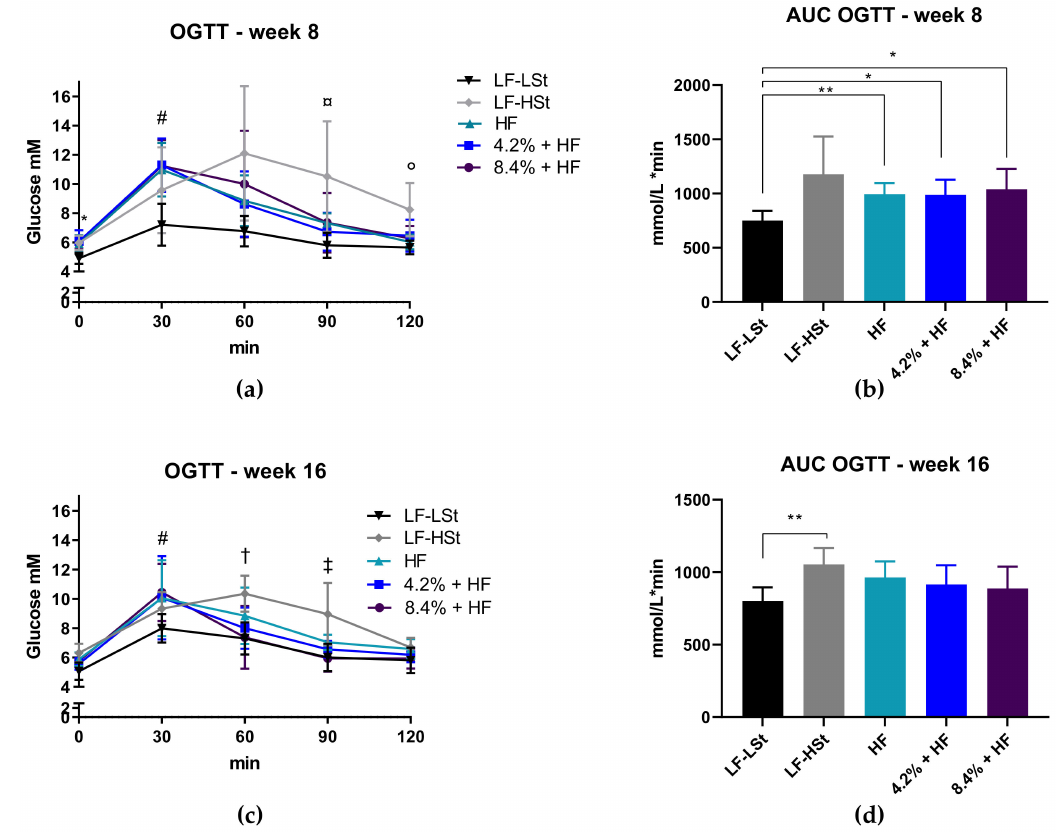
Figure 2. Oral Glucose Tolerance Tests. ( a ) Oral glucose tolerance test at week 8. Data are presented as means with SD and square root transformed data were analyzed by a repeated measures two-way ANOVA, and a Tukey’s test for multiple comparisons. n = 8 ( b ) Area under the curve for each group. Data are represented as means with SD, and analyzed by Welch ANOVA with a Dunnett’s test for multiple comparisons. n = 8 ( c ) Oral Glucose tolerance test week 16. Data are represented as means with SD, and analyzed by mixed effects model with repeated measures, and a Tukey’s test for multiple comparisons. n = 6–8 ( d ) Area under the curve for each group. Data are presented as means with SD and analyzed by a one-way ANOVA, with a Dunnett’s test for multiple comparisons. n = 6–8. For ( a , c ): * LF-LSt different from all, # LF-LSt different from all except LF-HSt, ¤ LF-LSt different from HF and LF-HSt, ◦ LF-HSt different from HF and LF-LSt, † LF-HSt different from all except HF, ‡ LF-HSt different from all. p < 0.05. For (b,d): * p < 0.05, ** p < 0.01. LF: Low Fat, HSt: High Starch, LSt: Low Starch, HF: High Fat, AUC: Area Under Curve, OGTT: oral glucose tolerance test, Min: